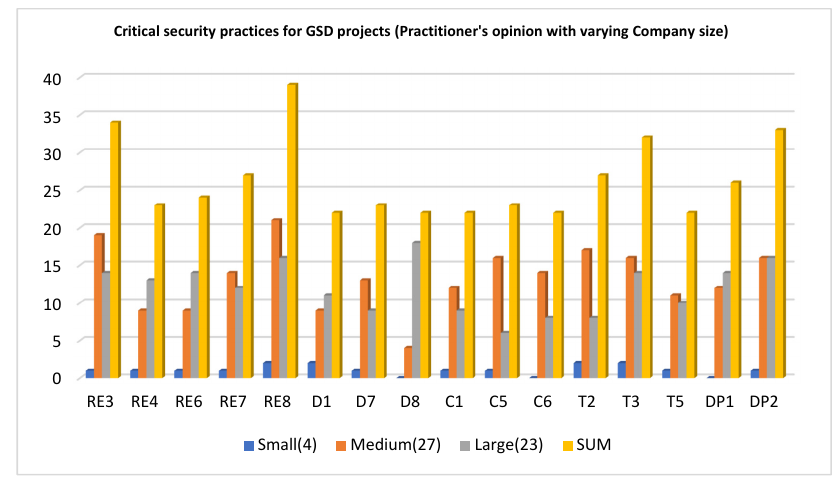
Figure 5. Critical security practices for GSD projects (opinion of practitioners with varying company size). H 0 = There is a correlation between company size and identified security practices. Table 4. Observed and expected values of selected GSD security practices by practitioners from varying size GSD companies. H 1 = There is no correlation between company size and identified security practices.